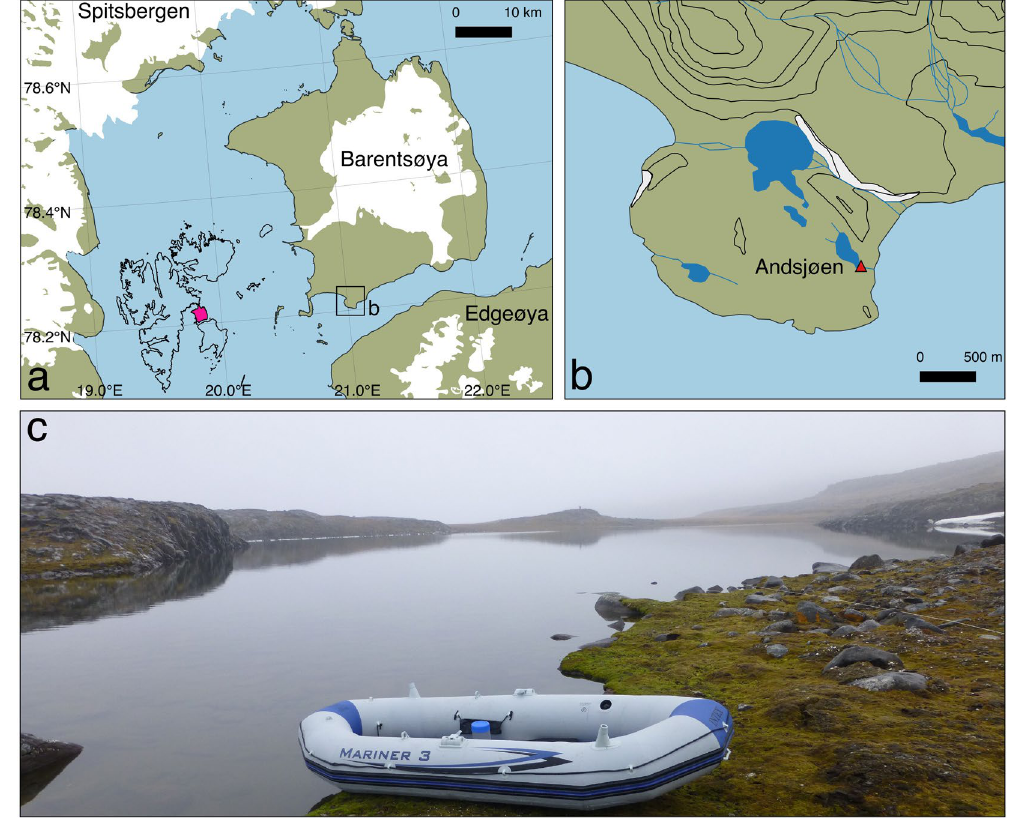
Figure 1. ( a ) Location of Barentsøya on the Svalbard archipelago (pink in inset). White areas are glaciers or ice caps, brown is tundra; ( b ) Zoom on southwest Barentsøya (Sundneset), and location of Andsjøen. Dark blue shows freshwater rivers/lakes. The maps in ( a ) and ( b ) were constructed using Quantum GIS (QGIS version 2.14); ( c ) Picture of Andsjøen taken on 25 August 2015 from the south towards the north (location shown by red triangle in ( b )). Source for ( a ) and ( b ): Norwegian Polar Institute, http://geodata.npolar.no. The Norwegian Polar Institute’s free map products are licensed under the Creative Commons Attribution 4.0 International (CC BY 4.0) license, ©Norwegian Polar